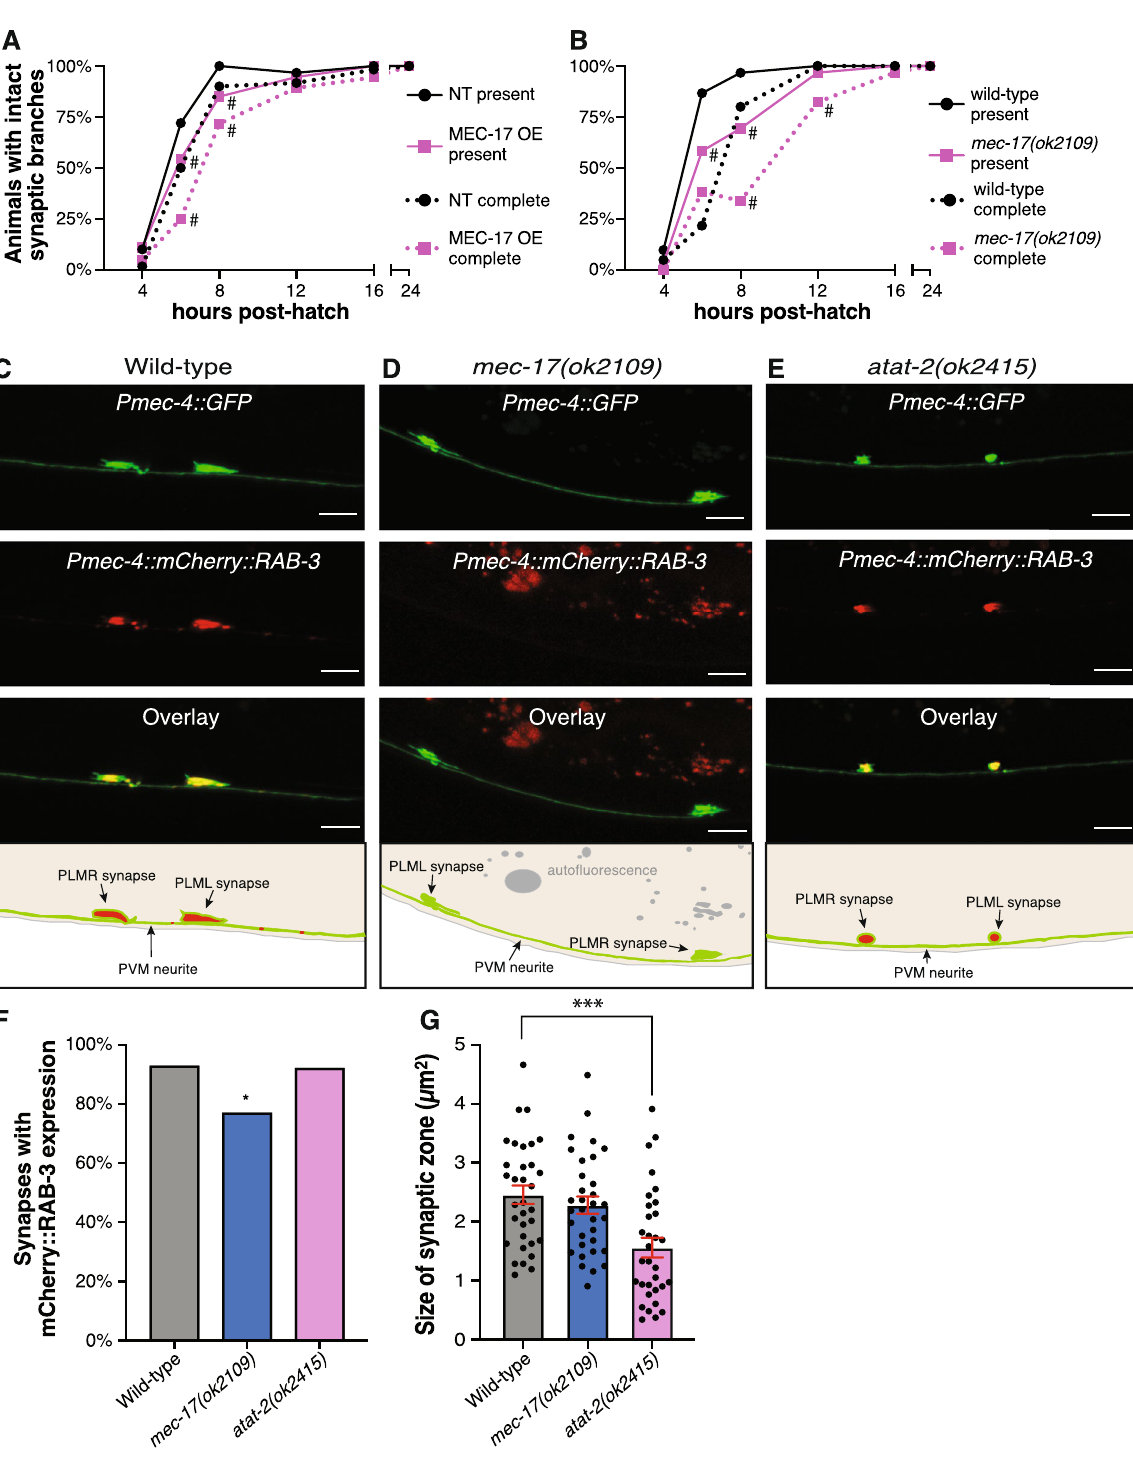
Figure 2. MEC-17 overexpression and loss disrupt PLM synapse development. Quantification of the number of animals displaying a branch from the main PLM axon shaft (present) and those with a branch extending into the ventral nerve cord (complete) in ( a ) animals with mec-17 overexpression (OE) or ( b ) mec-17 mutants. Both PLML and PLMR analyzed at 4, 6, 8, 12, 16 and 24 h post-hatch (different cohorts of animals used at each time point); n ≥ 30. # indicates P < 0.05 when comparing to the non-transgenic (NT, a) or wild-type (b) calculated from Fisher’s exact tests. ( c ) Maximum projection confocal images of the PLM synaptic sites in wild-type animals. The top panel displays the neurons expressing Pmec-4::GFP , the middle panel shows the pre-synaptic sites labelled with mCherry::RAB-3, the third panel is an overlay with co-localization displayed yellow-orange, and the bottom panel is a schematic of the overlay. Arrowheads point to synaptic expansions/accumulations; scale bars represent 5 μm. ( d,e ) Representative image of a mec- 17(ok2109) and atat-2(ok2415) mutant animal respectively, displayed as per panel c; scale bars represent 5 μm. ( f ) Number of synapses where mCherry::RAB-3 was visualized in wild-type, mec-17(ok2109) and atat-2(ok2415) animals where n ≥ 38; P values * < 0.05 from Fischer’s exact test. ( g ) Quantification of the pre-synaptic area labelled by Pmec-4::GFP in wild-type, mec-17(ok2109) and atat- 2(ok2415) animals; bars show mean ± SE; n ≥ 30; P values *** < 0.001 from unpaired t